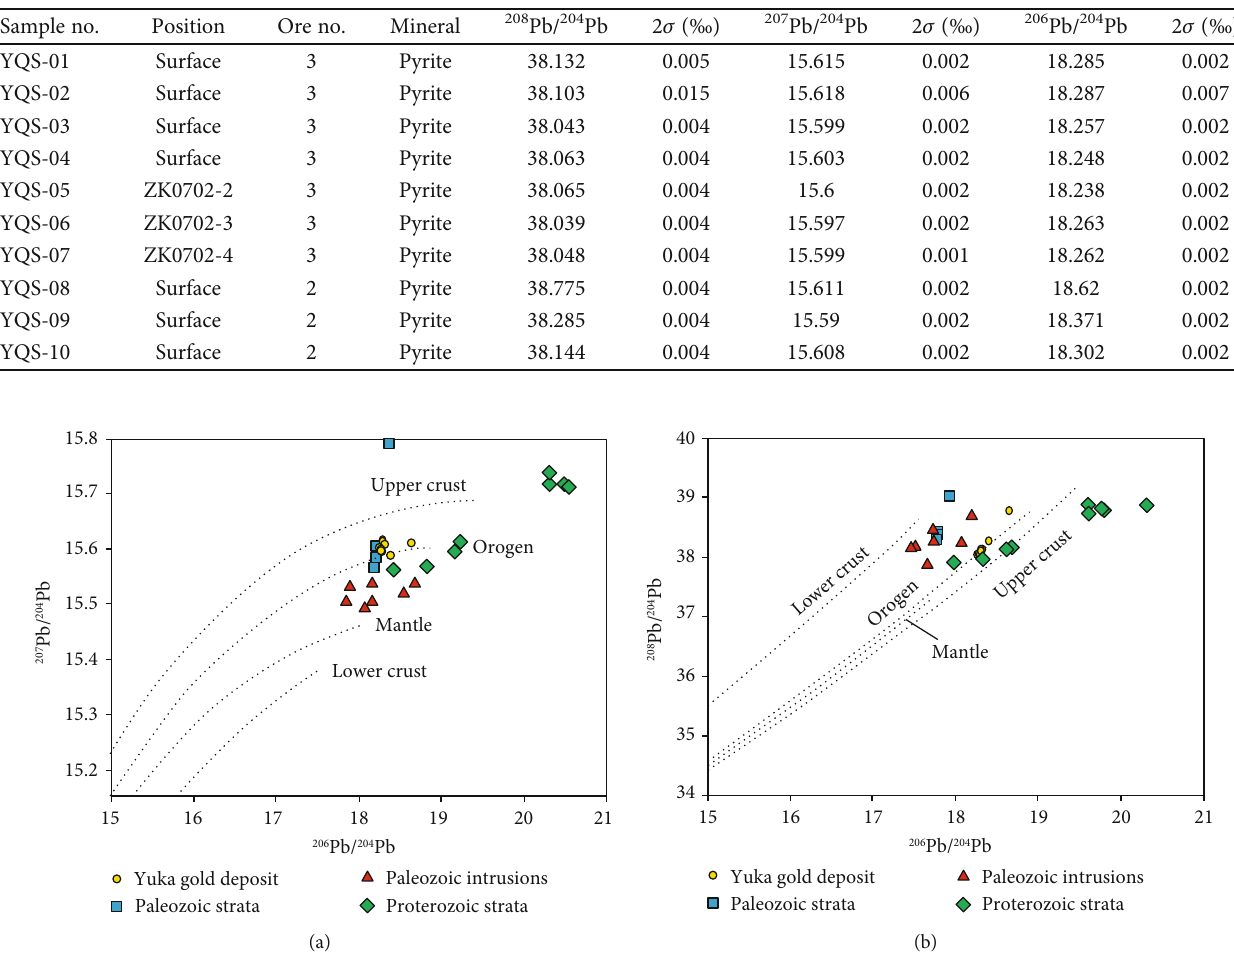
Figure 10: Lead isotopic compositions from the Yuka gold deposit. (a) 207 Pb/ 204 Pb vs. 206 Pb/ 204 Pb and (b) 208 Pb/ 204 Pb vs. 206 Pb/ 204 Pb. The evolution curves of the upper crust, lower crust, mantle, and orogen are from Zartman and Doe (1981). Data from Paleozoic strata are quoted from Zhu et al. [75]; data from Paleozoic intrusions are quoted from Guo and Chen [76]; data from Proterozoic strata are quoted from Zhang